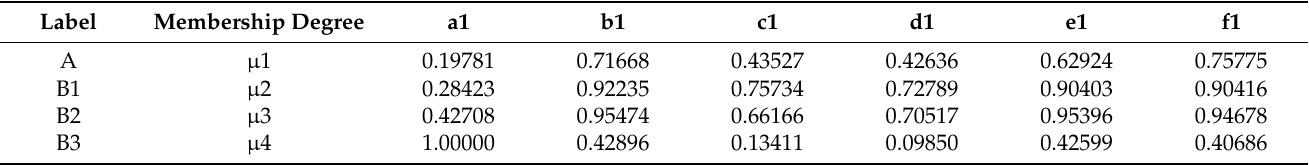
Table 10. Fuzzy set of leakage faults in reversing valve.